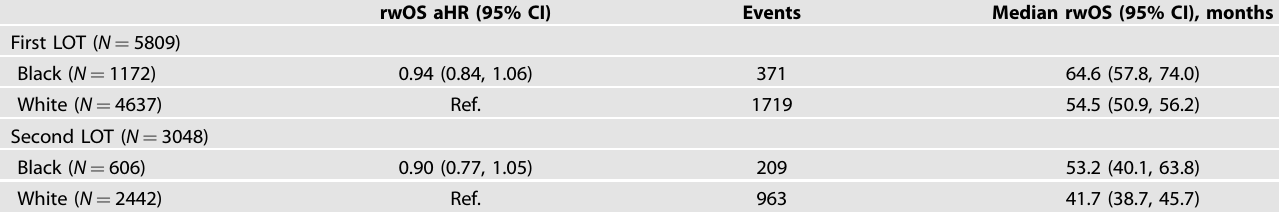
Table 2. Real-world overall survival analysis.